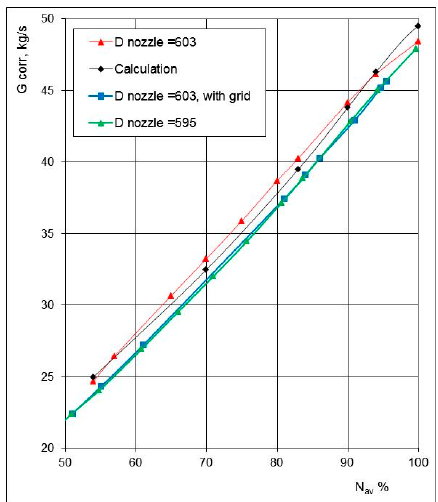
Figure 19. Total air flow of the fan as a function of average rotational speed.